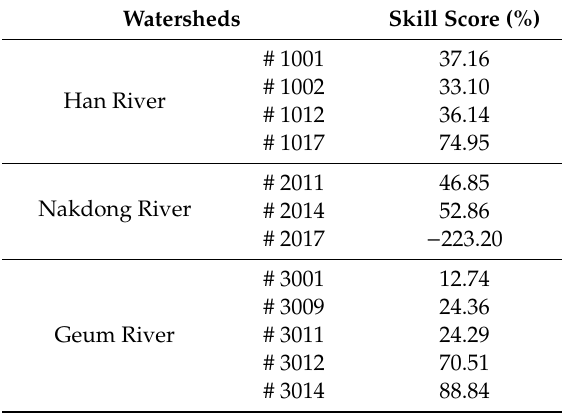
Table 4. Results of the leave-one-out cross-validation (LOOCV)